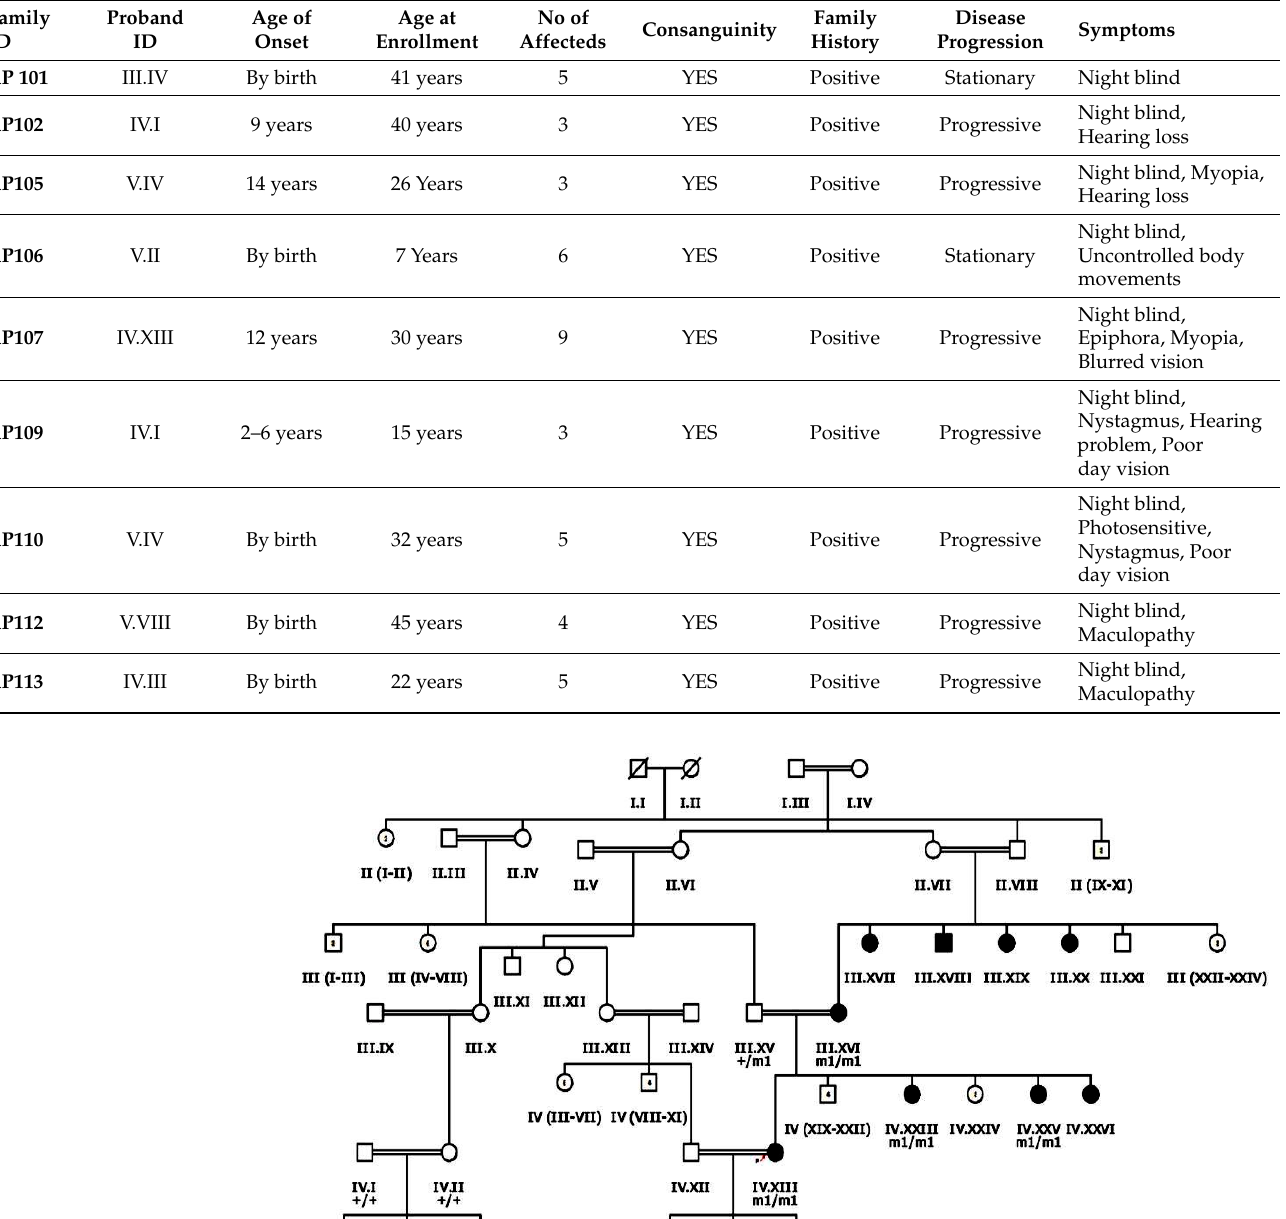
Table 1. Demographic and clinical data of nine inherited retinal dystrophies affected families enrolled for this study.